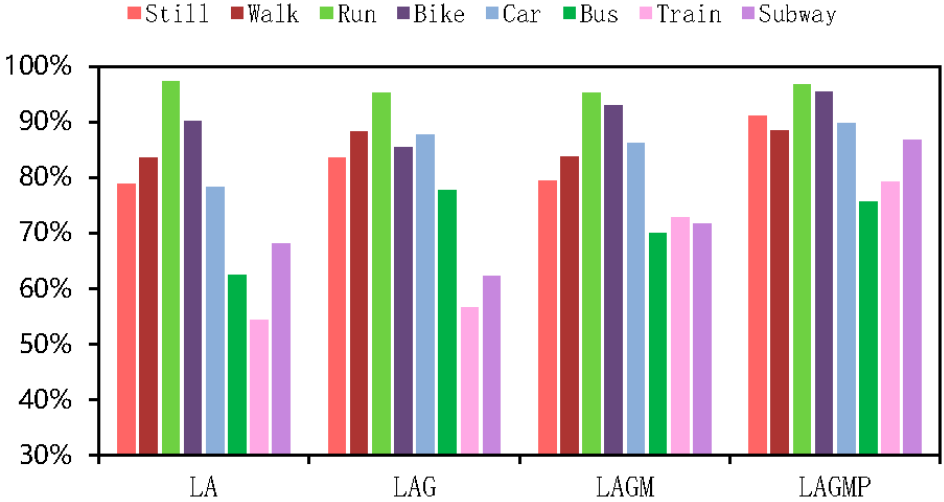
Figure 17. Precisions of DFTrans obtained using different sensor variables on the HTC dataset.